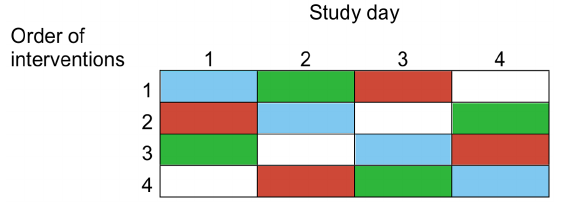
Figure 2. Randomization of the interventions according to a Latin Square design. Blue: Unpleasant ambiance + 3 glasses of sparkling white wine Green: Pleasant ambiance + 3 glasses of sparkling white wine Red: Unpleasant ambiance + 3 glasses of alcohol-free sparkling white wine White: Pleasant ambiance + 3 glasses of alcohol- free sparkling white wine.